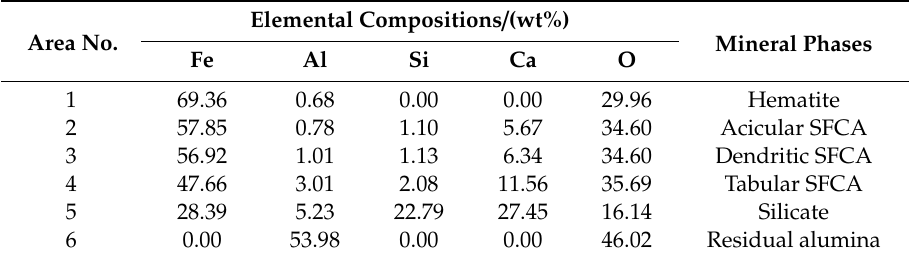
Figure 13. E ff ect of kaolinite on the characteristics of the bonding matrix (P: Pore; a → b: Rotate 90 ◦ to the right; ( a , b ) are the optical and SEM photographs of the reaction interface respectively; ( c ) is the photograph of line scan in ( b )). Table 8. EDS analysis results for areas in Figure